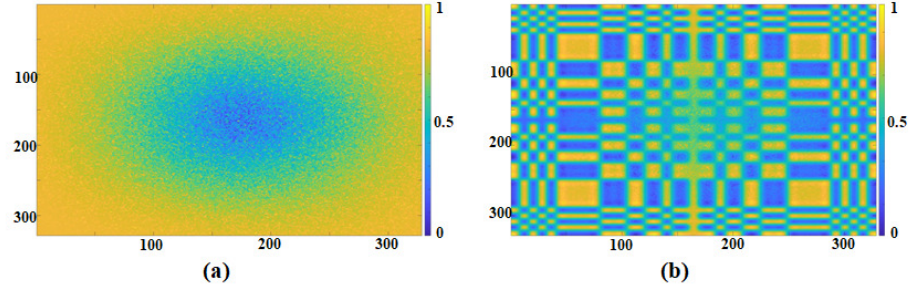
Figure 5. Simulated ( a ) and decoded ( b ) image for location 17 and TBR = 10.